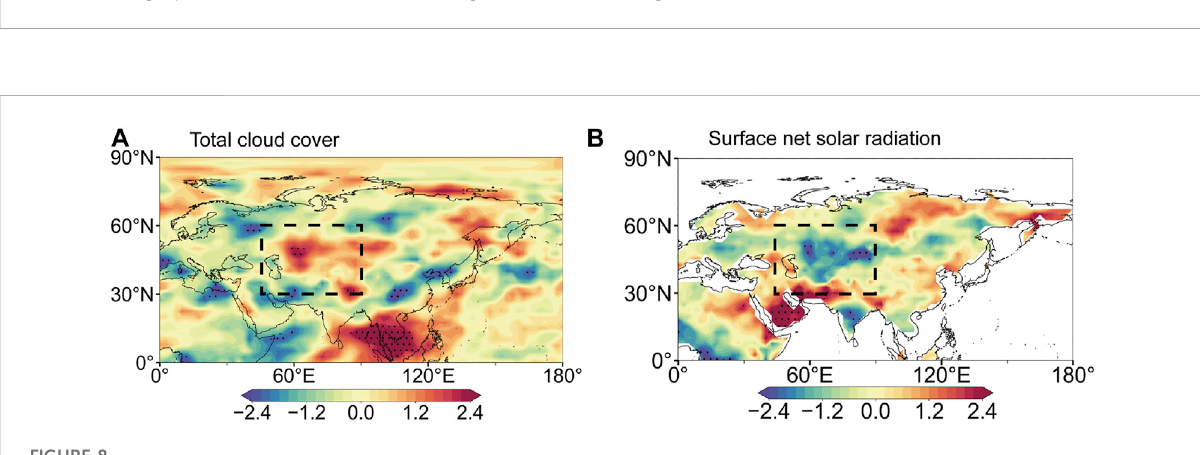
FIGURE 7 Correlation maps between (A) 200 hPa, (B) 500 hPa, and (C) 850 hPa geopotential height (GHT, color) and wind (vector) and SSN. Black dots marks regions where GHT differences are above 90% con fi dence level. The black vectors show the wind differences are over 90% con fi dence level. The wind and geopotential data at 850 hPa on the Qinghai-Tibet Plateau are ignored.